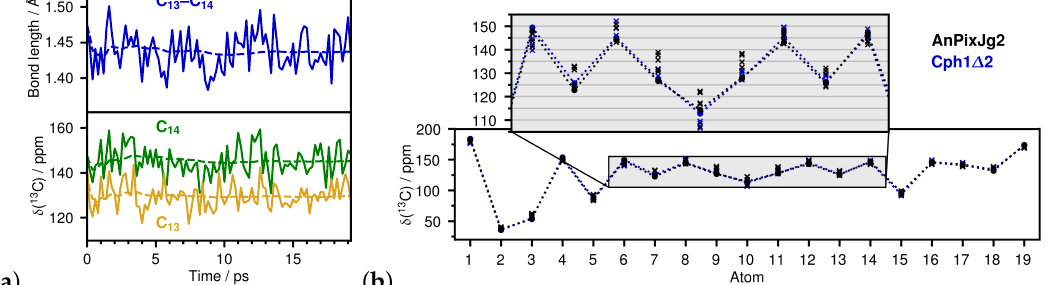
Figure 2. ( a ) Thermal fluctuations exemplified by bond length and 13 C chemical shifts of carbon atoms C 13 and C 14 in PCB along a quantum mechanics/molecular mechanics (QM/MM) molecular dynamics (MD) simulation of AnPixJg2 in its P r form (solid line) and running average (dashed line). For atom numbering see Scheme 1. ( b ) 13 C chemical shifts of PCB in AnPixJg2 (black) and Cph1 ∆ 2 (blue). Crosses mark the values computed from QM/MM MD trajectories while full circles indicate the experimental reference (dashed lines to guide the eye)